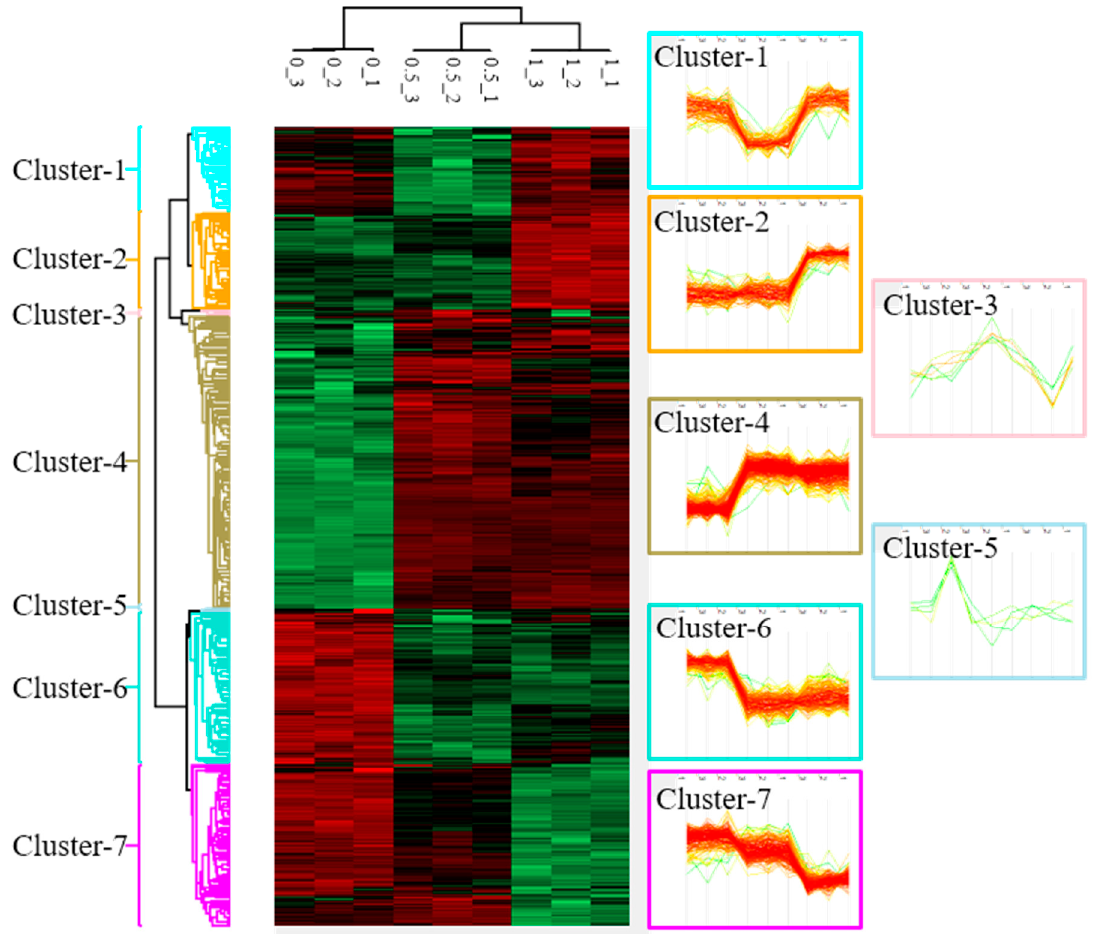
Figure 2. Cluster analysis of differentially expressed proteins (DEPs) in Mia PaCa-2 cells under different doses (0, 0.5, and 1 μ M) of betulinic acid (BA) treatment. Samples of each concentration were analyzed in triplicate. After normalizing average values of logarithmic intensities of each protein profile, 3316 proteins were identified and subsequently classified into seven clusters with distinct expression patterns. An ANOVA was applied to determine the statistical significance of DEPs using the threshold of a false detection rate (FDR) of <0.05. Results are presented as a heat map.